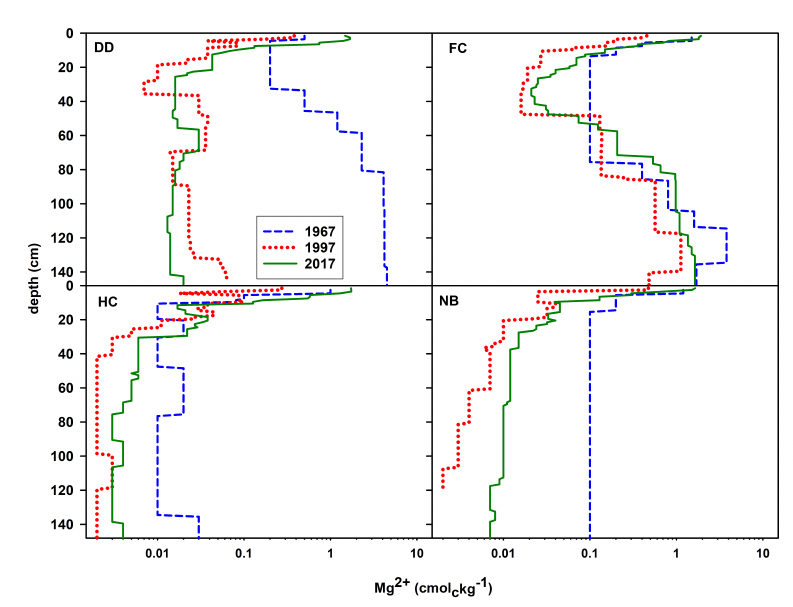
Figure 3. Soil exchangeable Mg profiles.